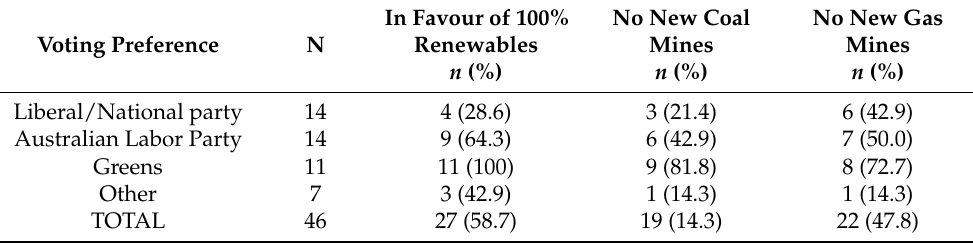
Table 2. Voting patterns and views on energy sources of all 46 participants eligible to vote in